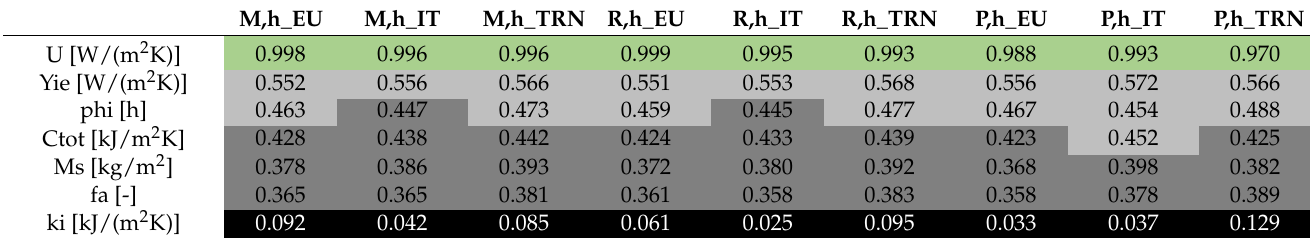
Table A4. Weight analysis of the thermo-physical attributes of opaque structures, for the winter period and with g gl =